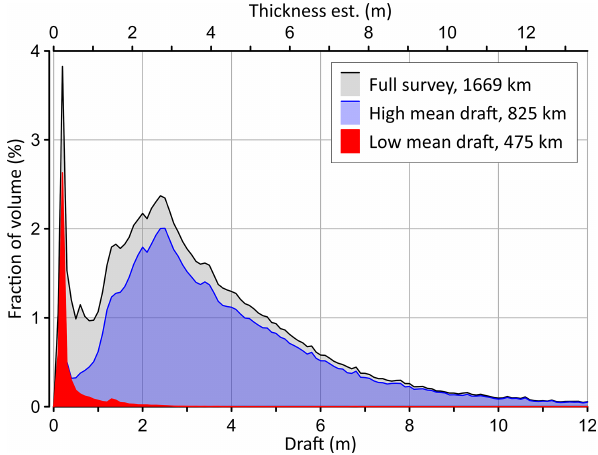
Figure 7. Fraction of ice volume versus draft. The curves represent all data, data from 33 segments of 25km with mean draft over 2.5m and data from 19 with mean draft under 1.5m. Thickness on the top axis is estimated as 1.13 ×